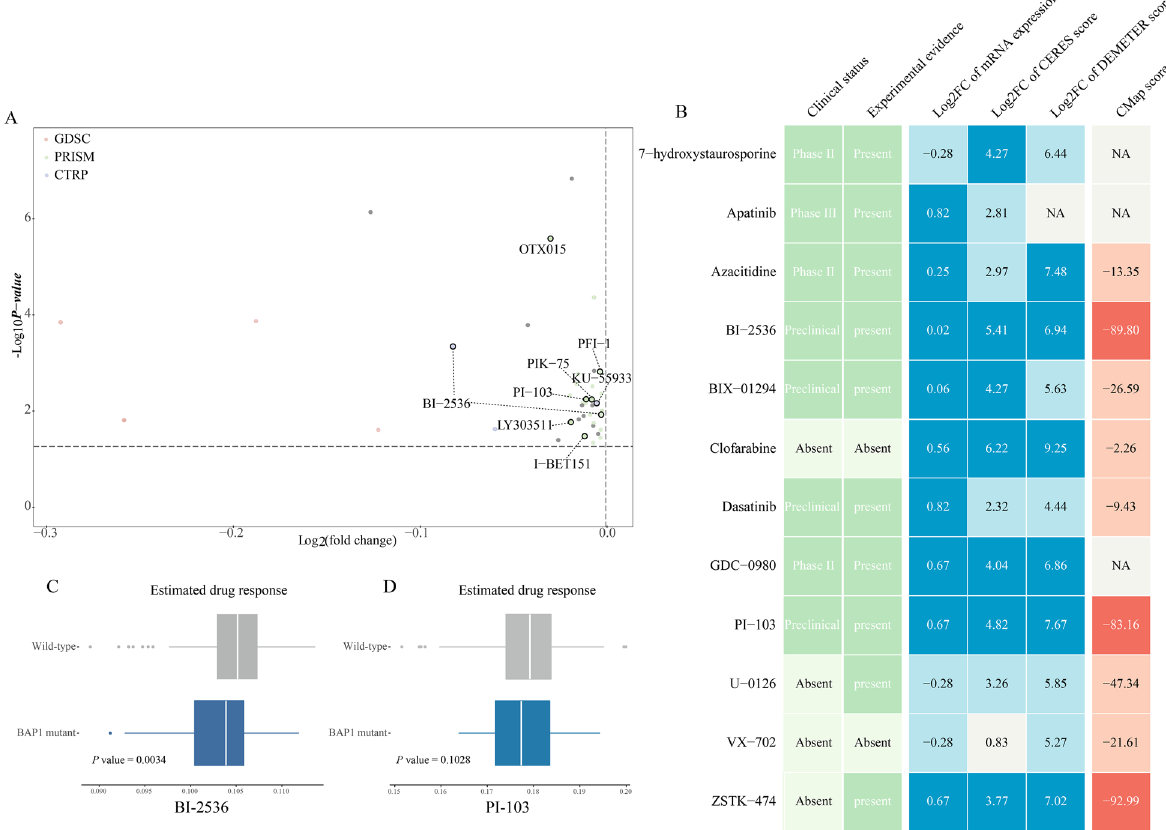
Figure 5. Estimating drug responses of BI-2536 and PI-103 across BAP1 mutated renal cancer patients. ( A ) Differential drug response analyses of identified 26 compounds with potential therapeutic efficacies on BAP1 - mutant ccRCC. The BRD4 and PRKDC inhibitors with significant response differences between BAP1 mutant and wild type groups were labeled on the plot. ( B ) Summarizing the current evidences, target gene expression, drug dependency and CMap analysis of candidate drugs. ( C ) Estimating the drug responses of BI-2536 and PI-103 in treating BAP1 mutated and wild-type RCC